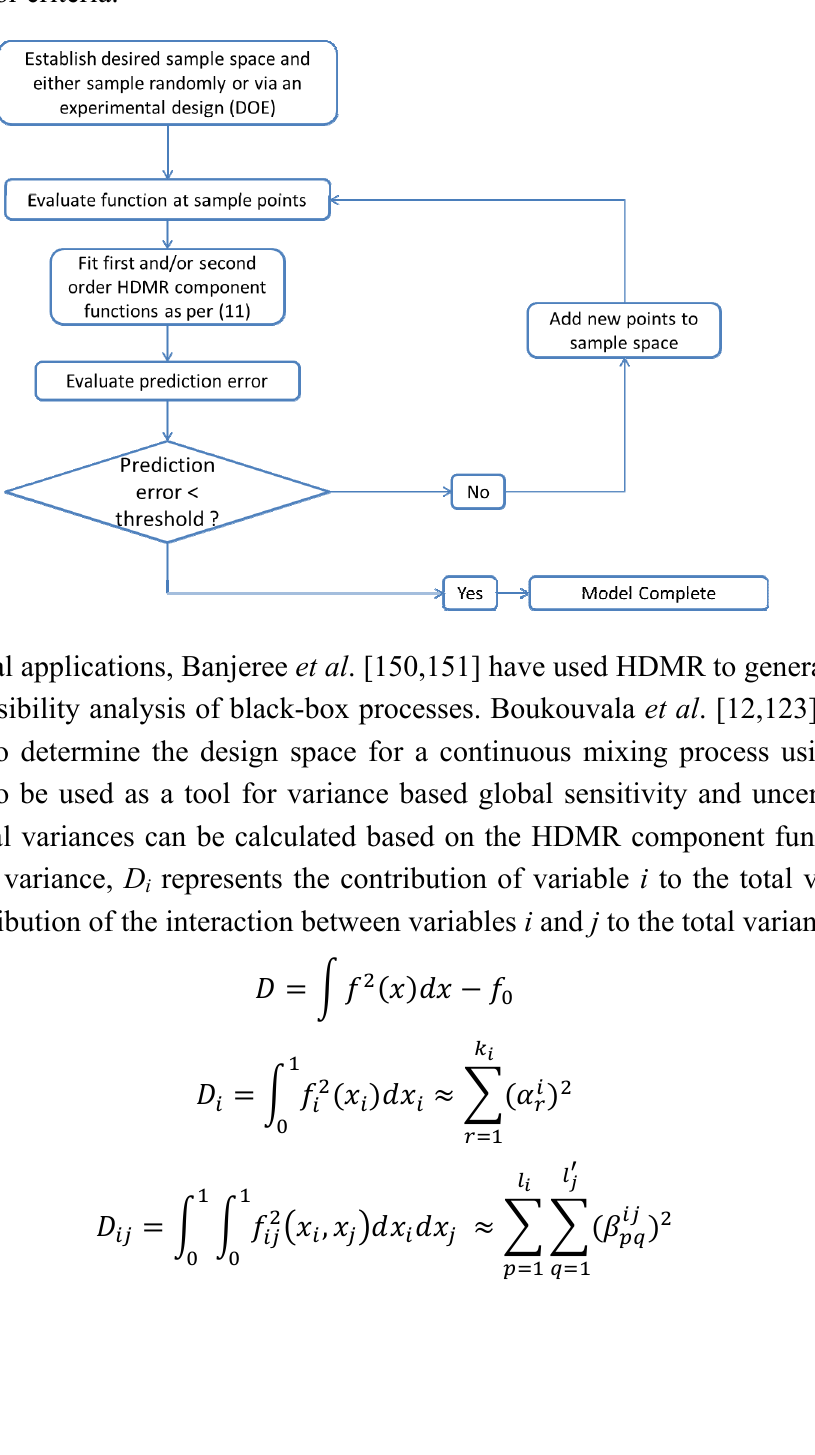
Figure 4. Algorithm for high dimensional model representation based on a minimum prediction error